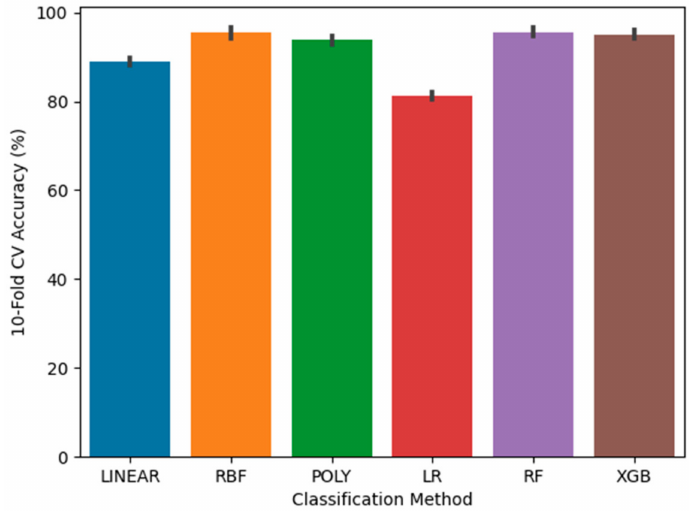
Figure 5. 10-fold CV accuracy for parameter-tuned classification methods (Case